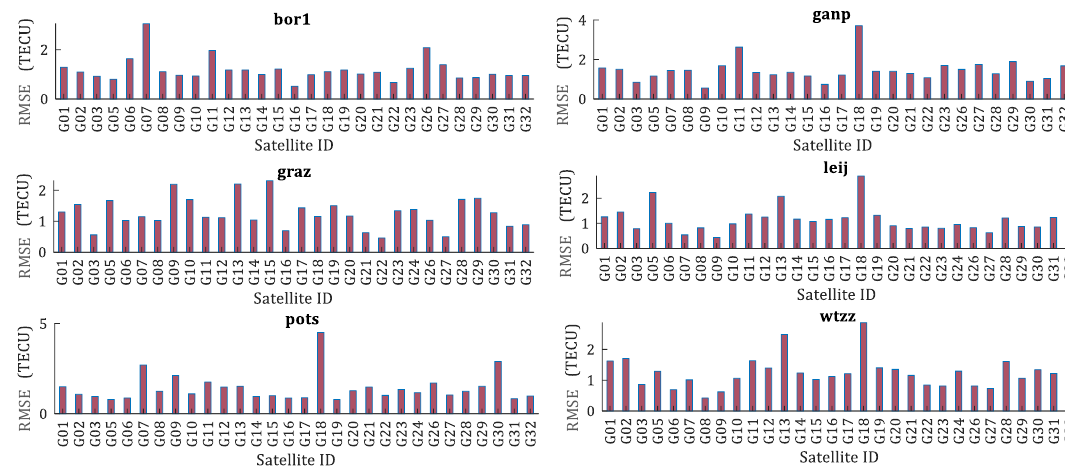
Figure 6. Root Mean Squared Error (RMSE) metric of the VTEC(TECU) predictions using LSTM method per station (bor1, grap, graz, leij, pots, wtzz) and per satellite ID (G1,.., G32 for GPS constellation).